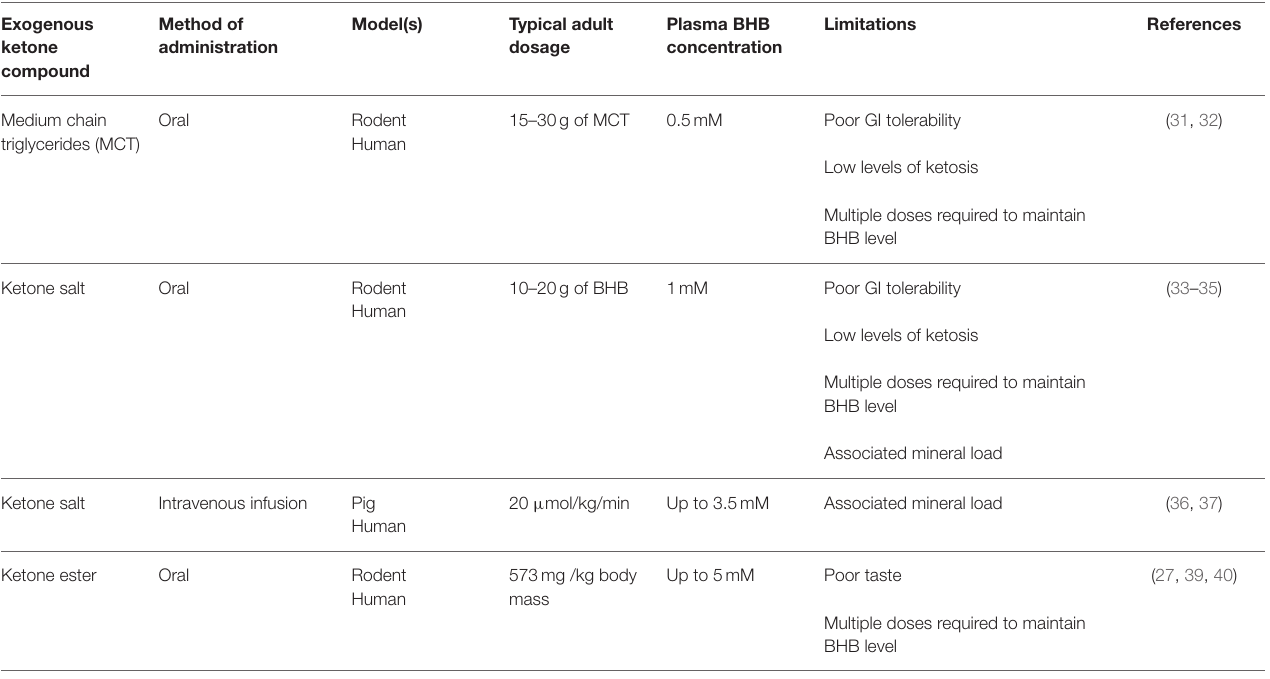
TABLE 1 | A summary of exogenous ketone